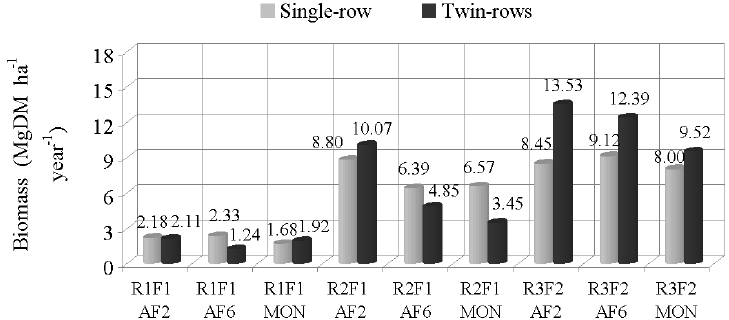
Figure 2. Biomass production (Mg DM ·ha − 1 ·year − 1 ) of clones AF2, AF6 and